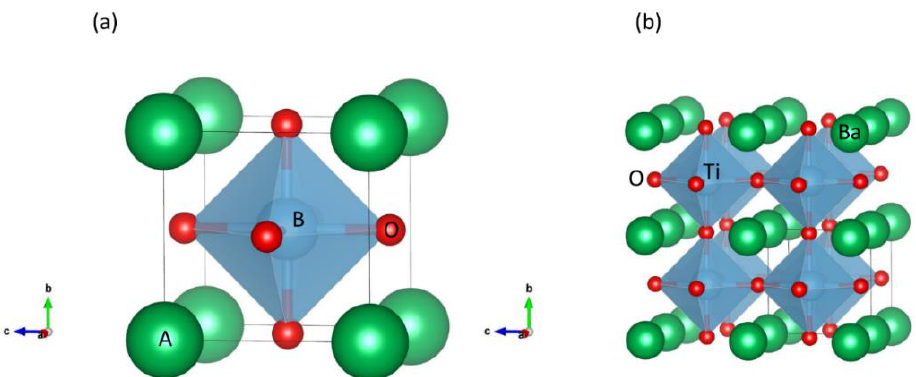
Figure 2. Stick and ball and stick schematic of the ( a ) ideal cubic perovskite structure unit cell, and ( b ) a supercell for BaTiO 3 structure.